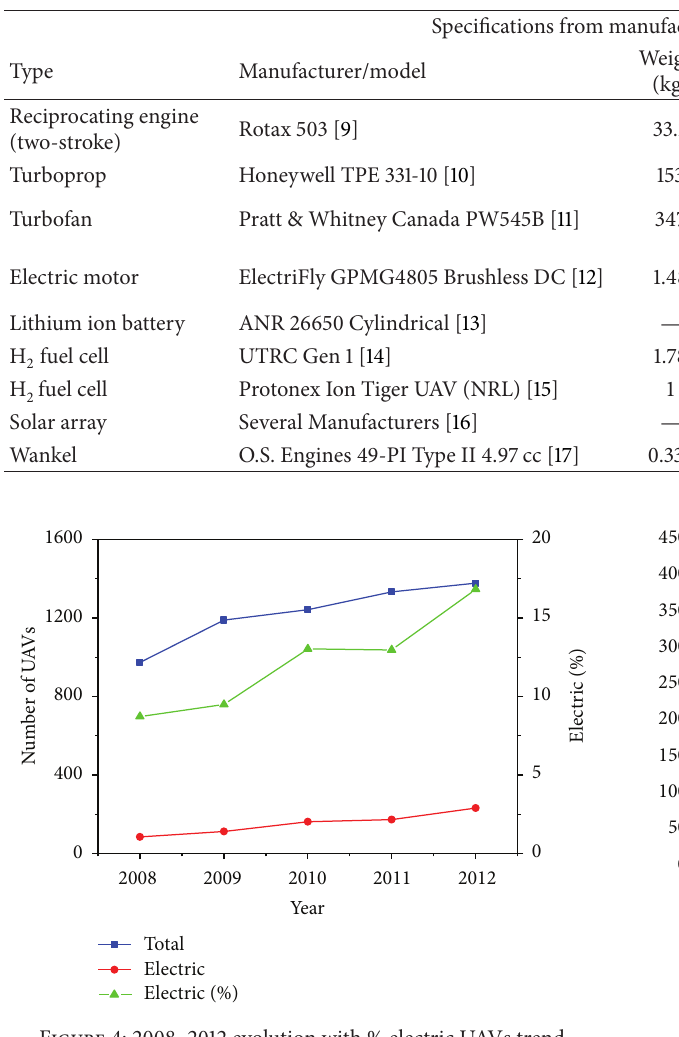
Figure 4: 2008–2012 evolution with % electric UAVs trend.